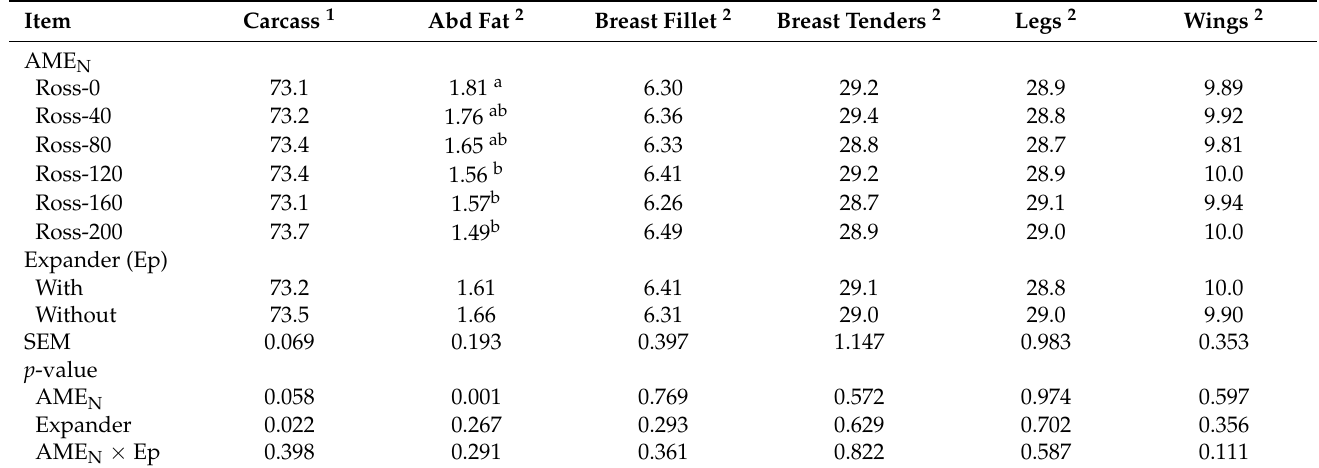
Table 12. Slaughter performance of broilers and abdominal fat,